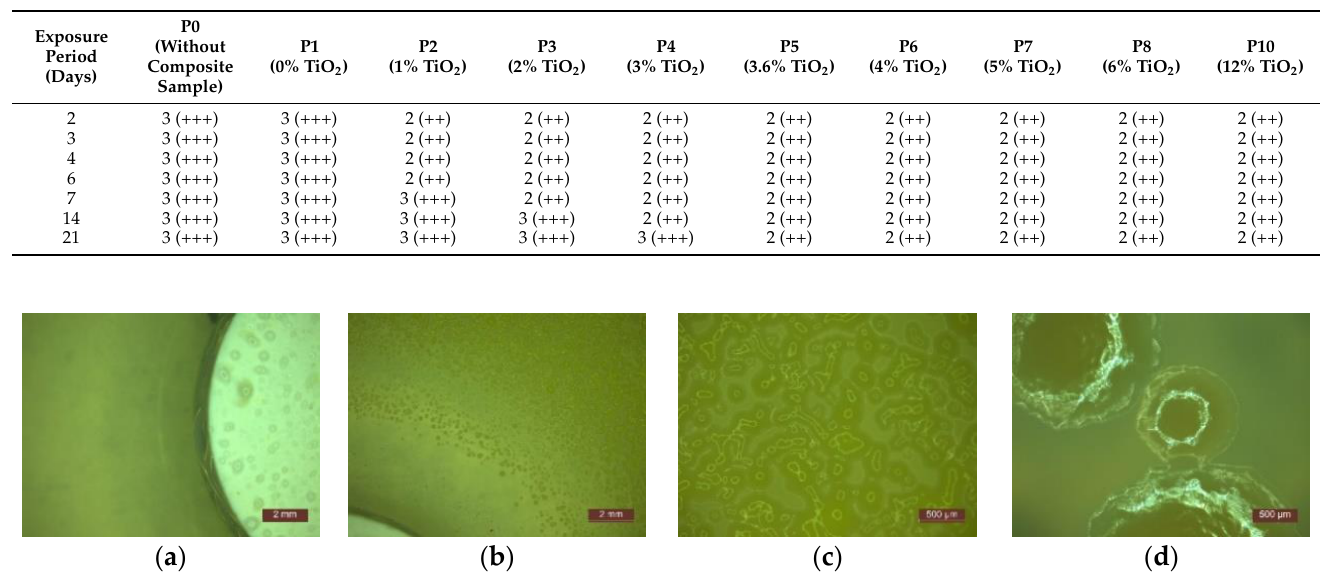
Figure 3. Inhibition halo size development after 2 days of exposure to bacteria Escherichia Coli , Pseudomonas Aeruginosa , Staphylococcus Aureus , and Streptococcus Pyogenes . (In the case of Pseudomonas Aeruginosa contamination, the EEA could not be quantified, because the control sample (0% TiO 2 ) did not show an inhibition halo). EEA: the percentage change in the diameter of the inhibition halo of the analyzed sample, indicating the effectiveness of the antibacterial effect.